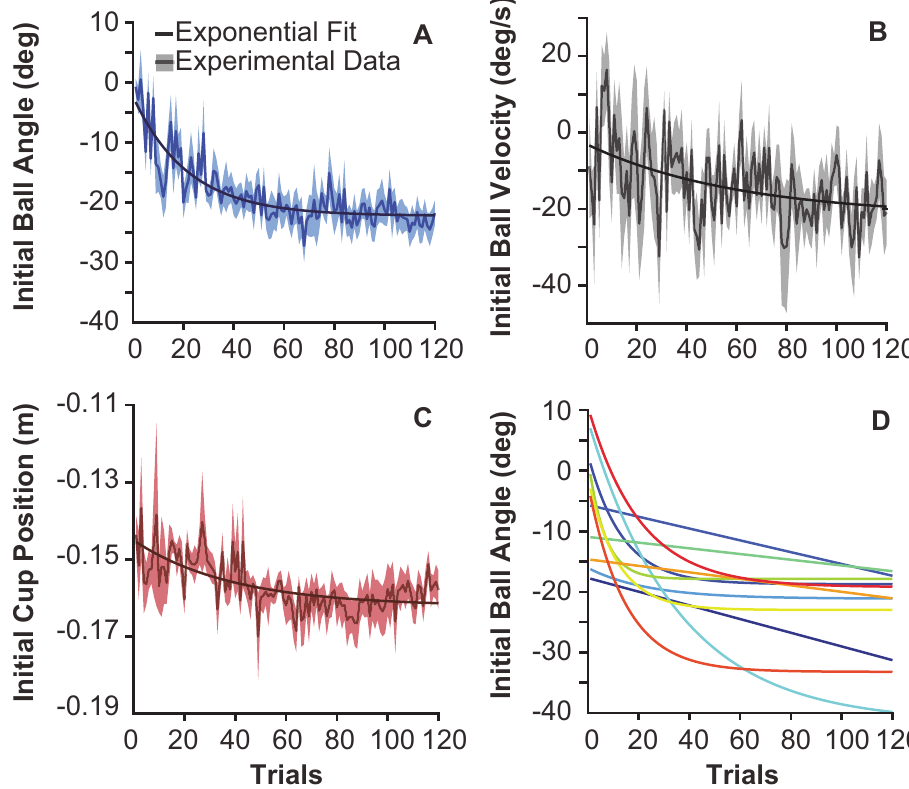
Fig 5. Average initial conditions over trials: A. Initial ball angle of 11 subjects across 120 trials. The solid blue line represents the mean, the shaded area represents the standard error across subjects (excluding their failed trials). The solid black line represents the exponential function fitted to the data: A = 19.86, τ = 21.82, B = -42.09, and R 2 = 0.75. B. Initial ball velocity; parameters of exponential fit: A = -14.59, τ = 58.38 and B = -2.86, and R 2 = 0.12. C. Initial cup position; parameters of exponential fit: A = 0.02, τ = 40.94, B = -0.18, and R 2 = 0.45. D. Exponential functions fitted to each individual subject’s initial ball angle over 120